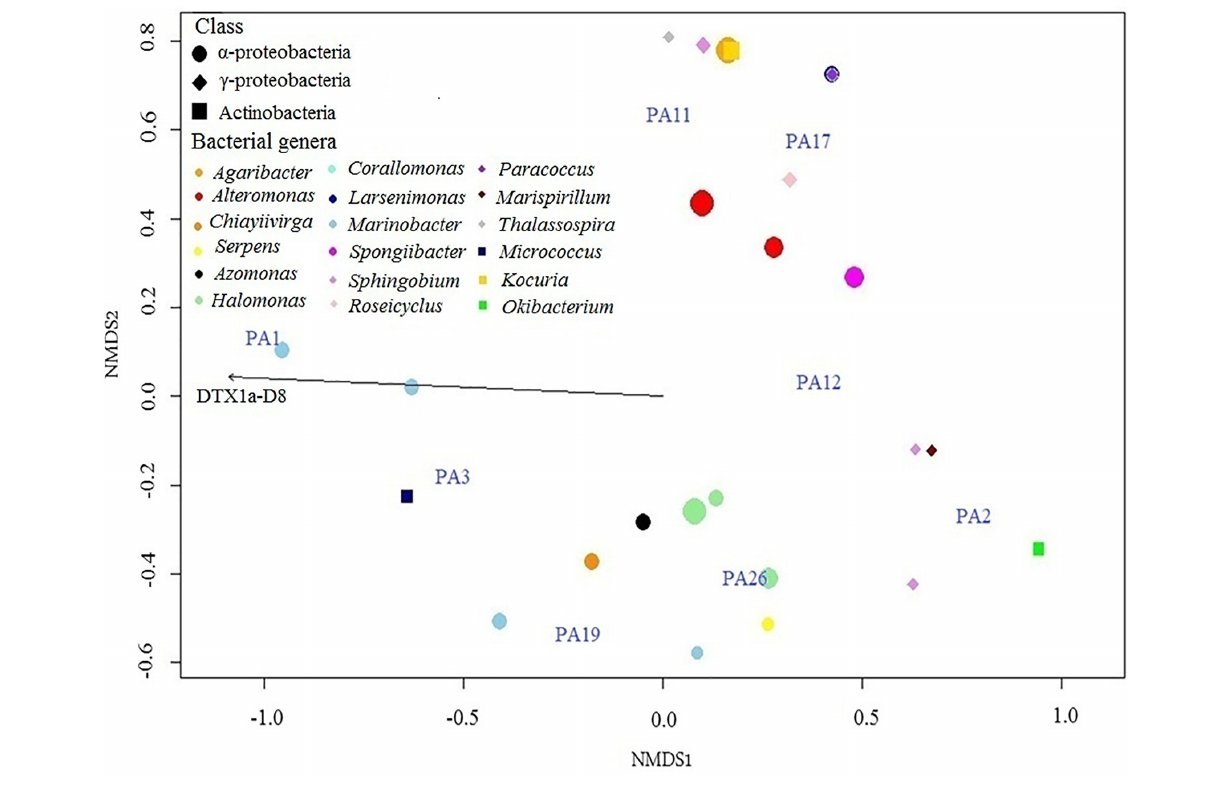
Frontiers in Marine Science |